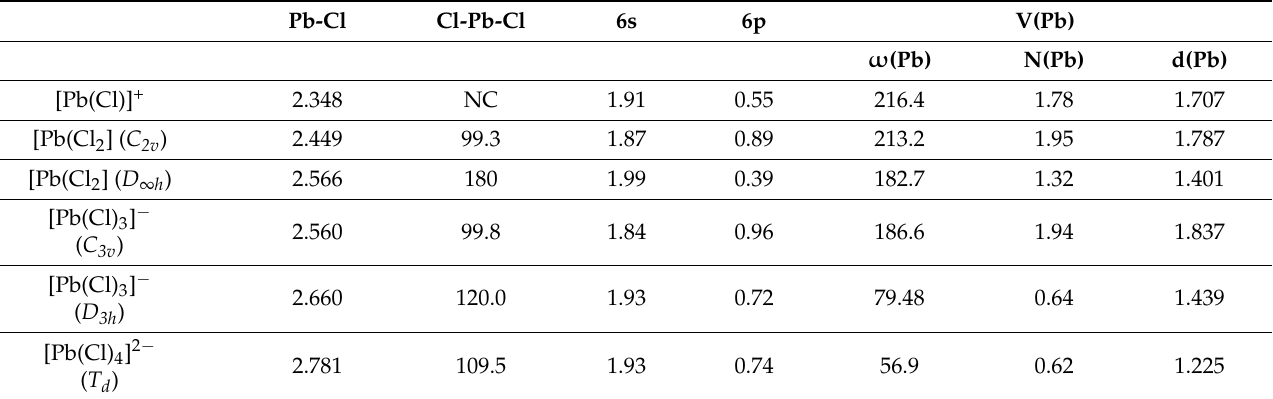
Table 2. Properties of the [Pb(Cl) n ] q complexes. Pb-Cl bond lengths in Angstroms. Cl-Pb-Cl angle in degrees. Electronic population of the 6s and 6p shells of lead from NBO analysis. Volume ( ω (Pb) in Å 3 ), population (N(Pb) in electrons) of lead valence basin and distance (d(Pb) in Å) of the V(Pb) ELF attractor and cation.